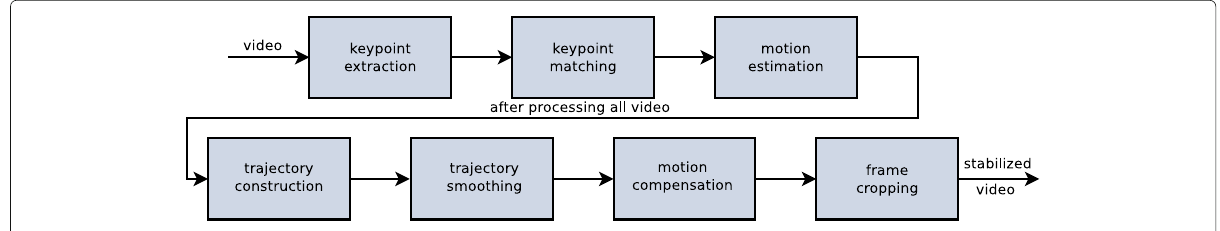
Fig. 1 Main steps of the proposed digital video stabilization